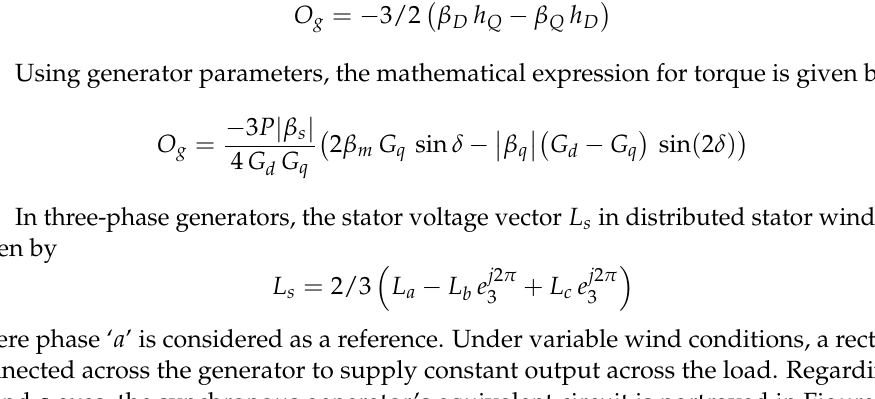
Figure 3. Recti fi er connection diagram. Six voltage vectors together with two zero voltage vectors as shown in Figure 4 are engendered by the recti fi er. The six voltage vectors are distanced at 60 degrees apart from each other. The voltage vectors are given as (